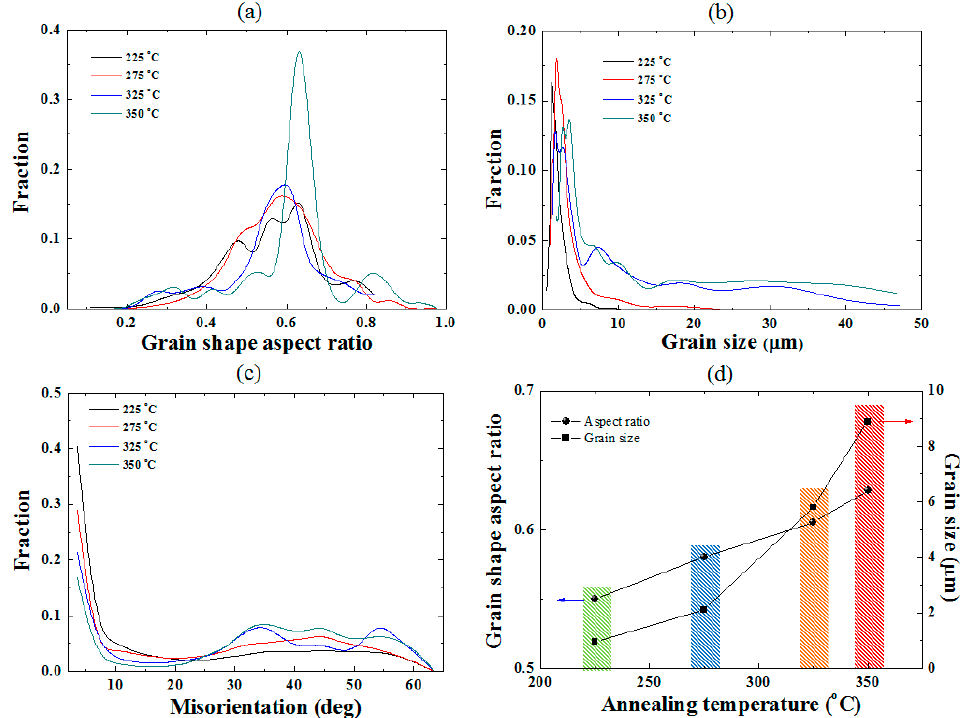
Figure 7. ( a ) Grain shape aspect ratio, ( b ) grain size, ( c ) grain boundaries misorientation and ( d ) average aspect ratio and grain size values of the DSR-deformed 6061 Al alloy annealed at different temperatures for 1 h. The columns used in Figure 7d are corresponding to the investigated samples remarked in Figure 5a.